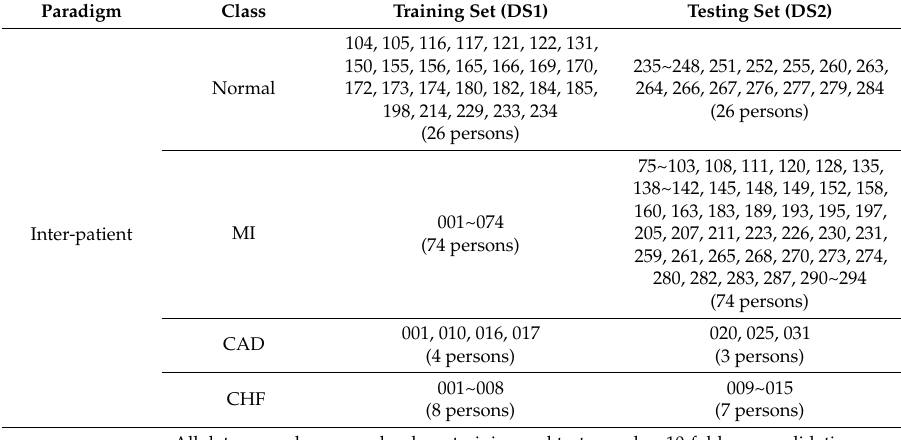
Table 3. The details of the data distribution